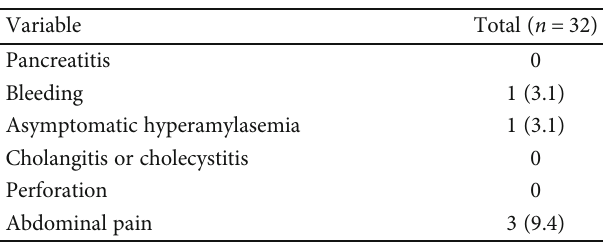
Table 3: Adverse event